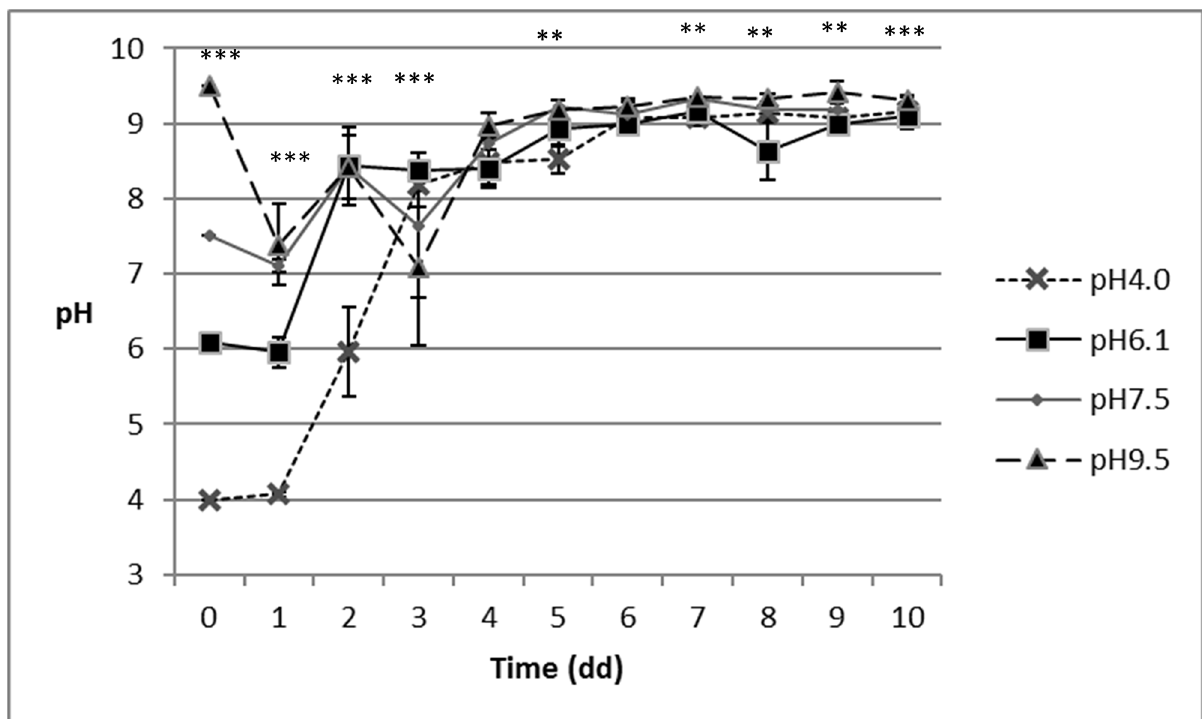
Fig 3. Changes in the pH over the course of the experiment, as a result of the feeding system and pH treatment. TFS: total amount of diet provided at the beginning (480g on